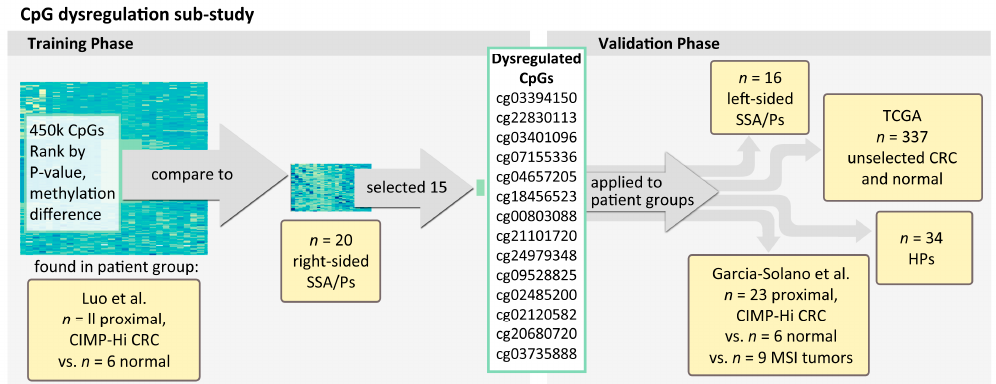
Figure 1. Study design diagram. The independent groups of patients assessed in the studies are depicted in yellow. The patients involved in training and validation phases of the CpG dysregulation study. CIMP, CpG Island Methylator Phenotype; CRC, colorectal cancer; TCGA, The Cancer Genome Atlas; HPs, hyperplastic polyps; MSI, microsatellite instability.